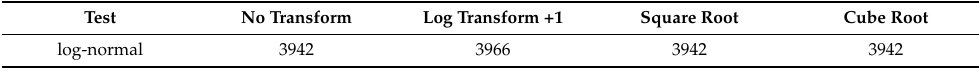
Table 16. Non-batch by category, tail of ST, AD